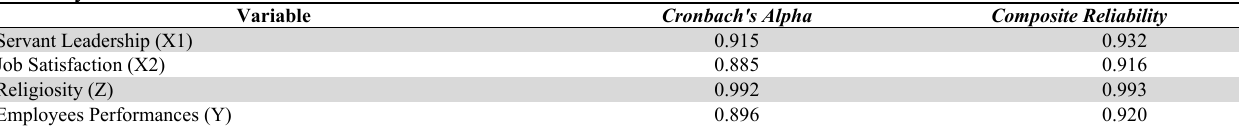
Reliability Test